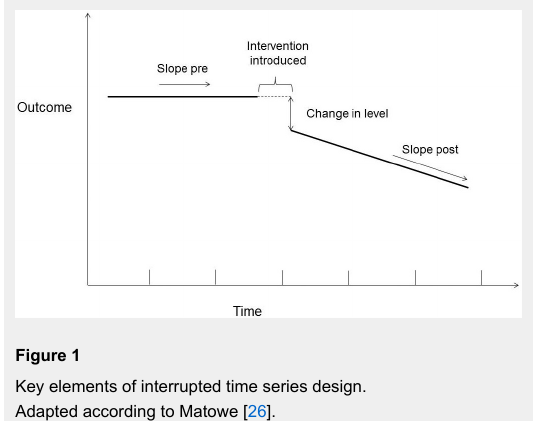
Key elements of interrupted time series design. Adapted according to Matowe